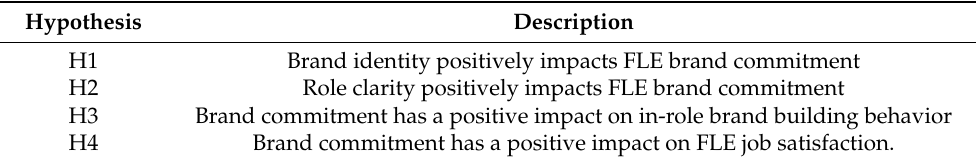
Figure 1. Antecedents and consequences of brand commitment of front-line employees proposed theoretical model. Table 1. Proposed hypothesis.